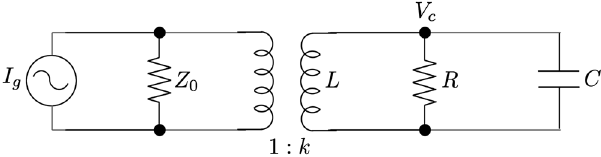
FIG. 15. Equivalent circuit of a cavity with a power